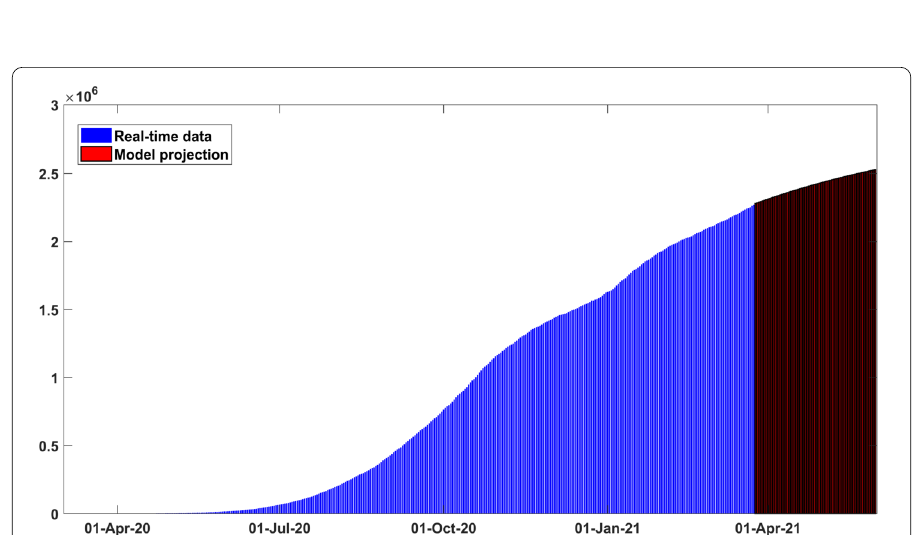
Figure 5 Cumulative infected cases fitted and projected for Argentina from early March to 2020 late May